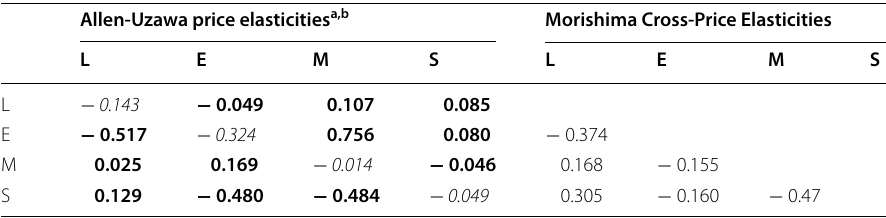
The bold values are the elasticities of substitutions a The values below the main diagonal are the elasticity of the price of the inputs in the rows with respect to the price of the input in the column. b Similarly, the values above the main diagonal are elasticities of the variables indicated in the columns with respect to the prices of the variables indicated in the rows. Note that cross-price elasticities are not symmetric because they are share-